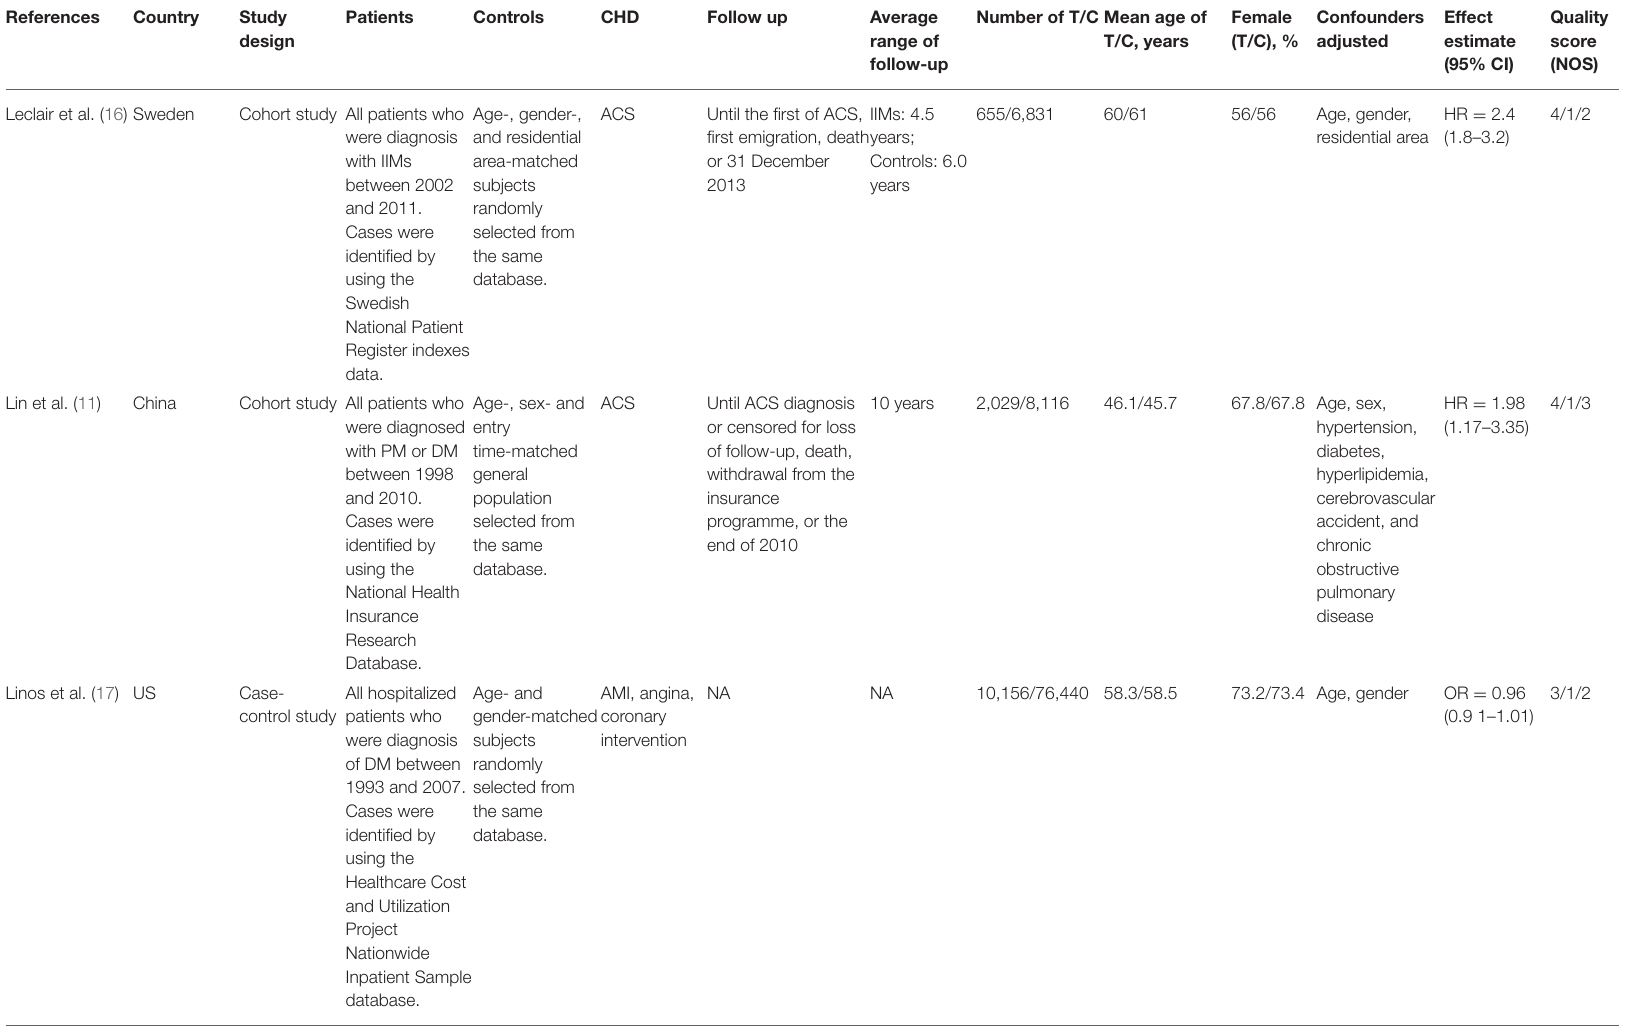
TABLE 1 | Main characteristics of the included studies on CHD in this